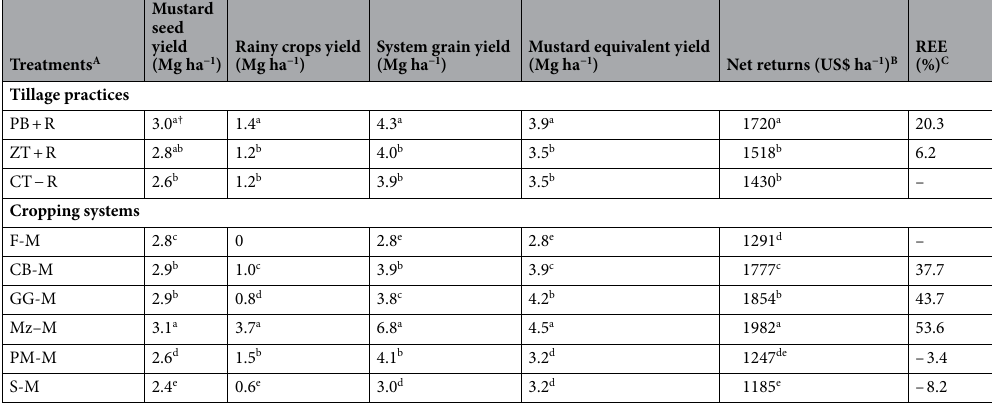
(Table 1) followed by CB-M and GG-M. The seed yield of mustard and other crops in the system improved in the permanent beds might be due to better soil physicochemical and biological properties, and nutrient availability that are related to tillage and residue management practices. Higher productivity and profitability in CA-based management was reported in mustard 22 and sesame-based cropping system 23 compared with mono-cropping.